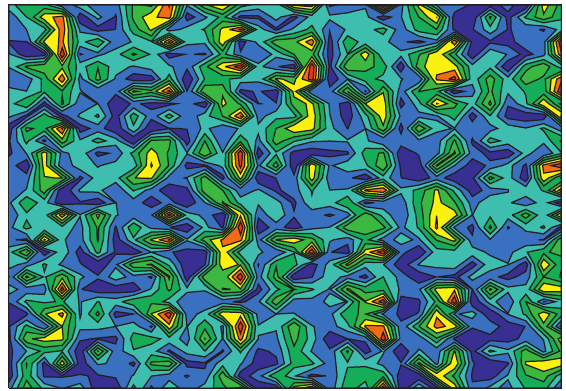
Figure 6: Optical flow diagram of continuous video frames.